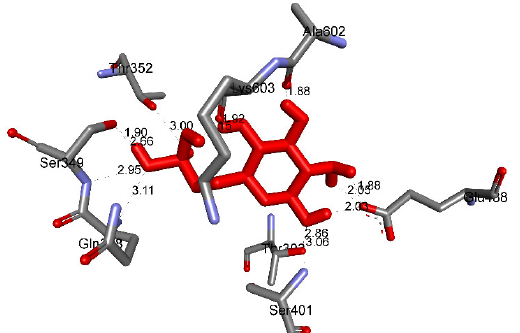
Figure 25. The hydrogen bonds from active atoms on pose 83, one small ligand which is available in enzyme 2VF5, to active residual amino acids on enzyme 2VF5.